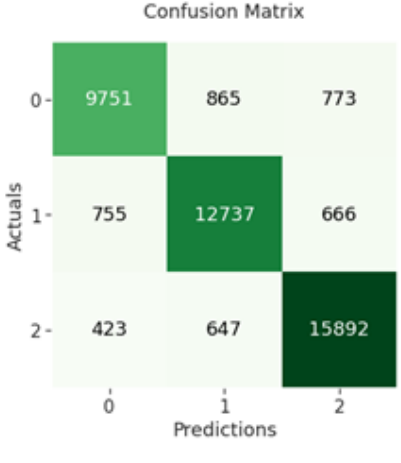
Figure 5. RNN confusion matrix.